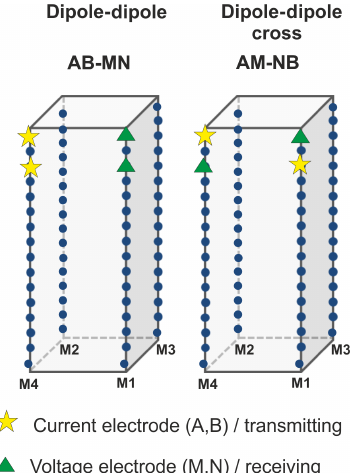
Figure 2. Schematic diagram (not to scale) of the ERT array in- stalled at the Svelvik CO 2 Field Lab. Shown as well are typical electrode configurations used in cross-well